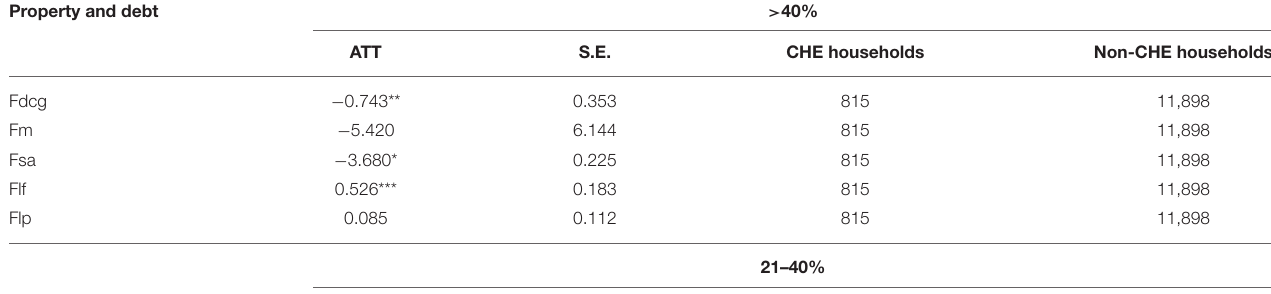
TABLE 7 | The ATT of CHE on household property and debt. Property and